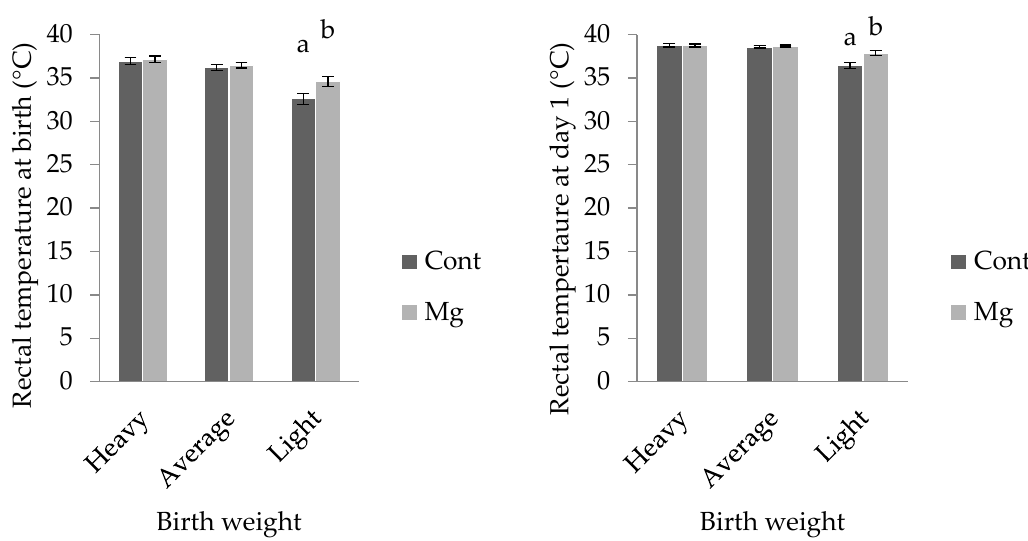
Figure 4. Mean ± s.e.m rectal temperature (°C) at birth and at one day of age for piglets classed as heavy (>1.8 kg), average (0.8 kg to 1.8 kg), and light (<0.8 kg) from sows fed a standard lactation diet (Cont) and those supplemented with 21 g/day MgSO 4 (Mg) prior to farrowing. a,b Means within weight on day of measure not having the same superscript are significantly different ( p < 0.05).